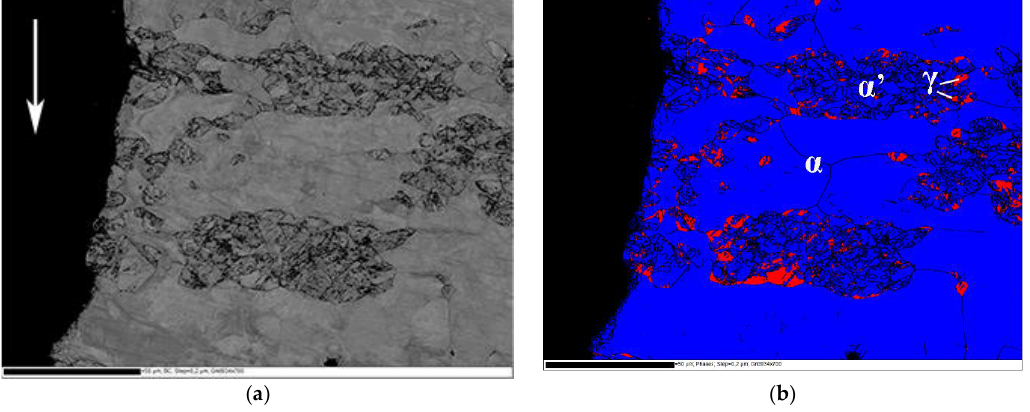
Figure 5. A backscattering electron image ( a ) and EBSD phase map ( b ) of the fracture path in steel B constant load specimen. The direction of crack propagation is marked with an arrow in ( a ).